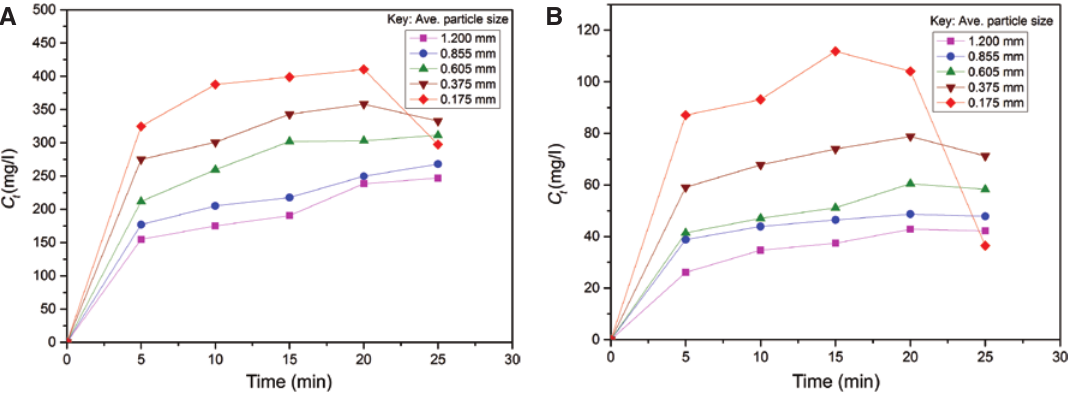
Figure 9: Effect of particle size on the rate of solid-liquid extraction of andrographolide from Andrographis paniculata (AP) in the green solid-liquid extraction at 80 ° C for solid-liquid ratio of (A) 1:10 (g ml -1 ) and (B) 1:50 (g ml -1 ).